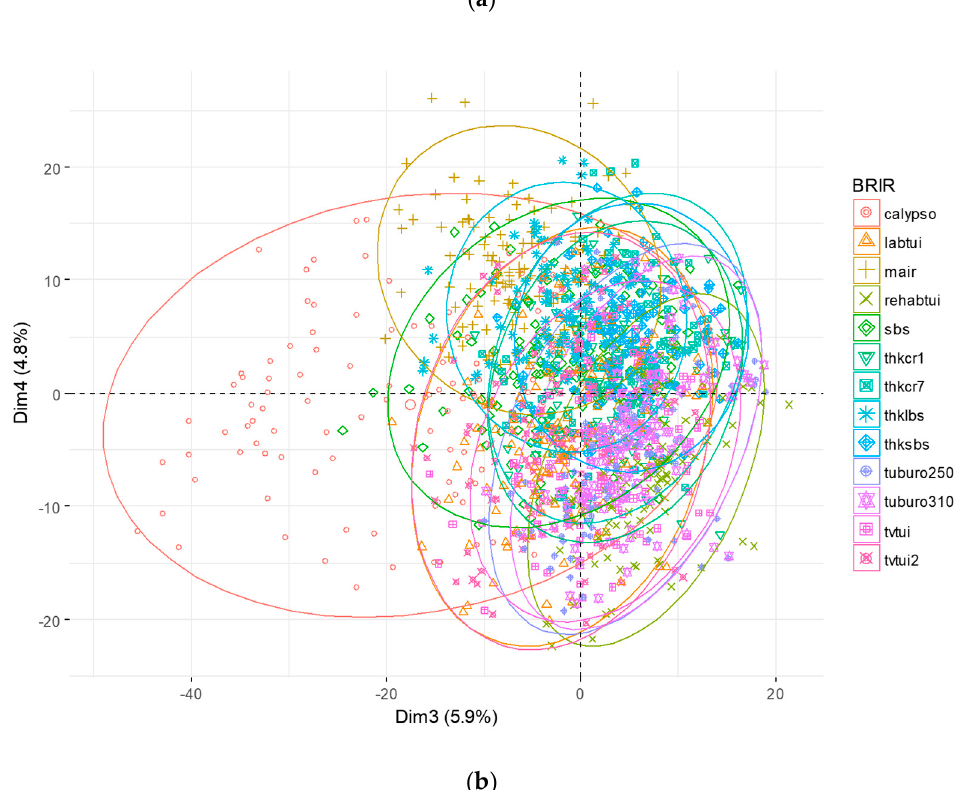
Figure 6. Results of the PCA for dimensions 3 and 4: ( a ) variable plot; ( b ) audio recordings. Ellipses represent a concentration of the scores for each BRIR set with 95% confidence boundaries around group means.